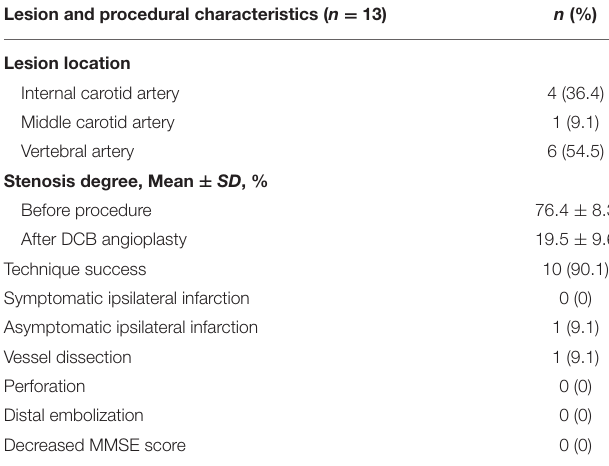
TABLE 2 | Lesion and procedural